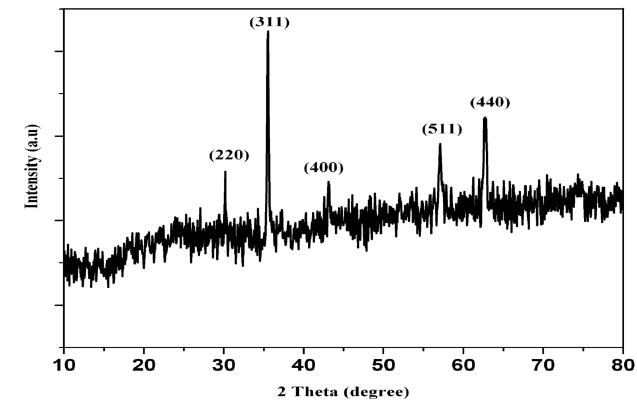
Figure 1. XRD pattern of synthesized magnetite nanoparticles using [BMIM][TfO] ionic